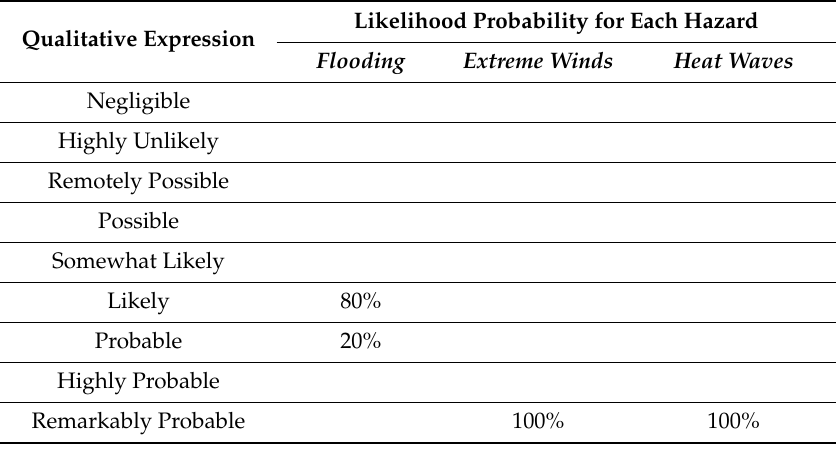
Table 5. Expected annual likelihood for anticipated hazards for CLIRMI mine.